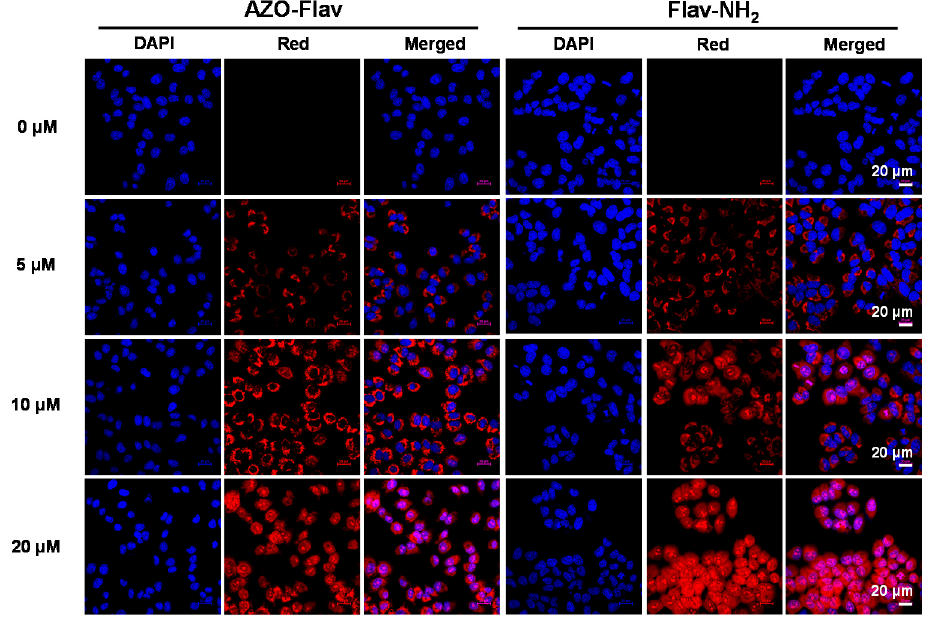
Figure 7. Dose-dependent cellular uptake of AZO-Flav and Flav-NH 2 at different concentrations (0, 5, 10, and 20 μ M) incubated for 60 min under hypoxia. 5, 10, and 20 µ M) incubated for 60 min under